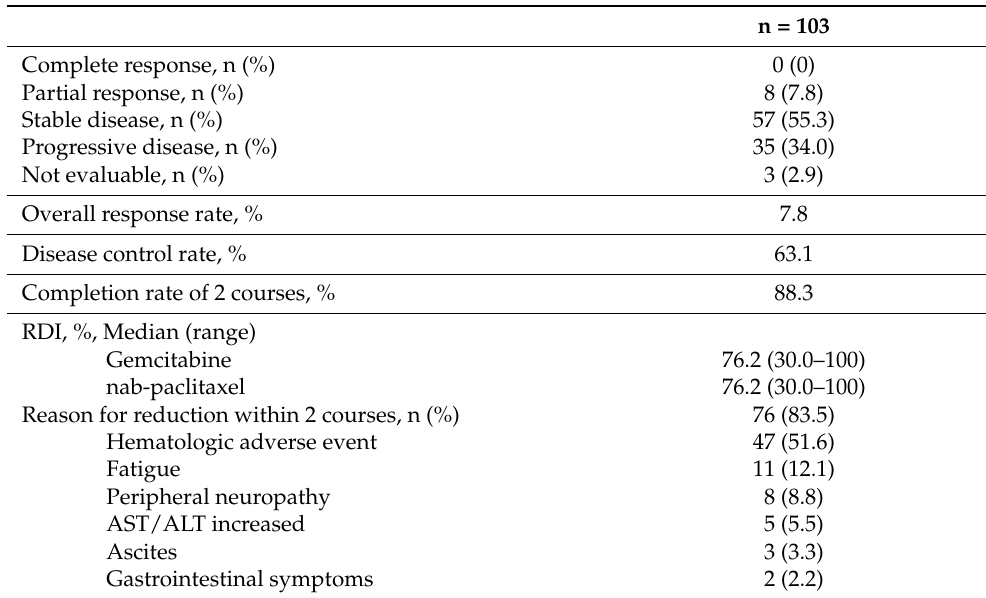
Figure 1. Overall survival ( a ) and progression-free survival ( b ). OS, overall survival; CI, confidence interval; PFS, progression-free survival. Table 3. Outcomes of second-line gemcitabine plus nab-paclitaxel.